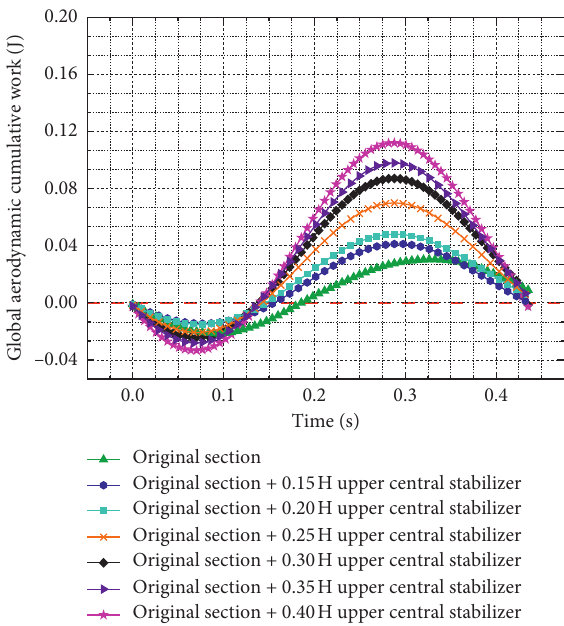
Figure 20: The local energy input of the lower